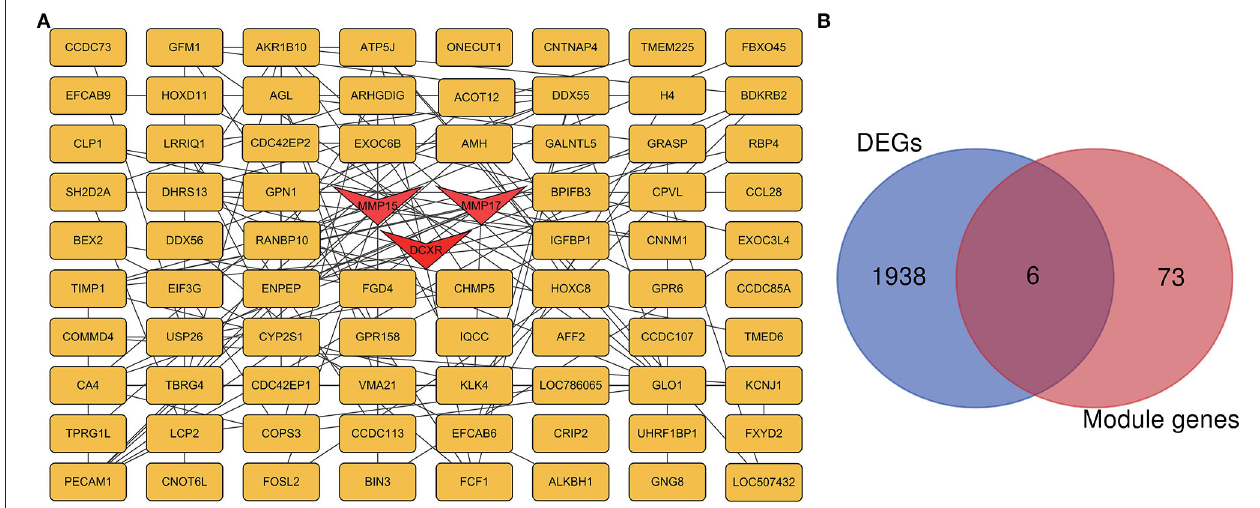
FIGURE 8 | PPI network of hub genes in green and light yellow modules. (A) Green and light yellow module, with 79 nodes and 119 edges. Triangular nodes represent hub genes. (B) The blue circle is the differential gene, the red circle is the blue module and the light yellow module gene, and the common gene is the junction of the two circles.